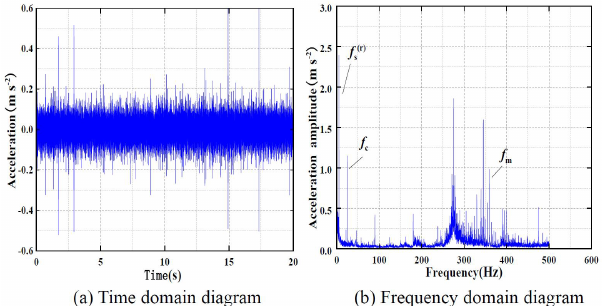
Figure 11. Vibration acceleration signal of the gearbox at n = 1500rpm.